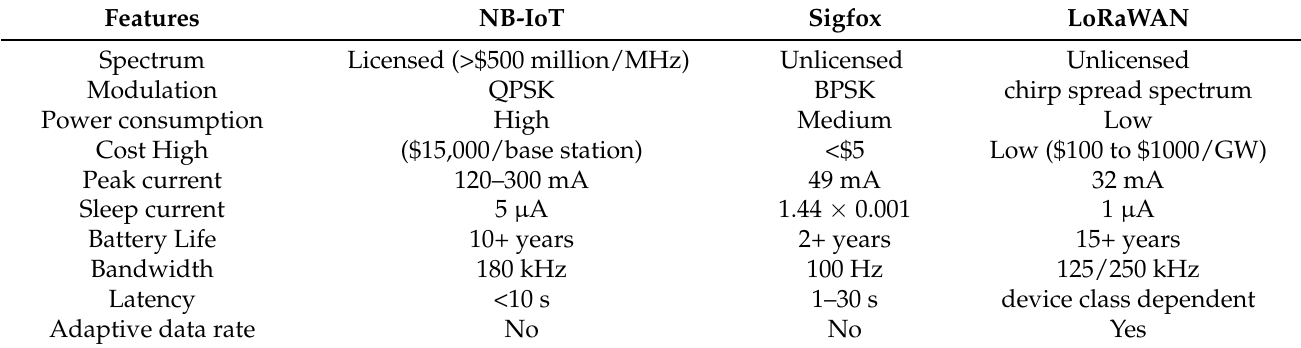
Table 1. LoRaWAN Advantages Compared with NB-IoT and Sigfox [1–3].